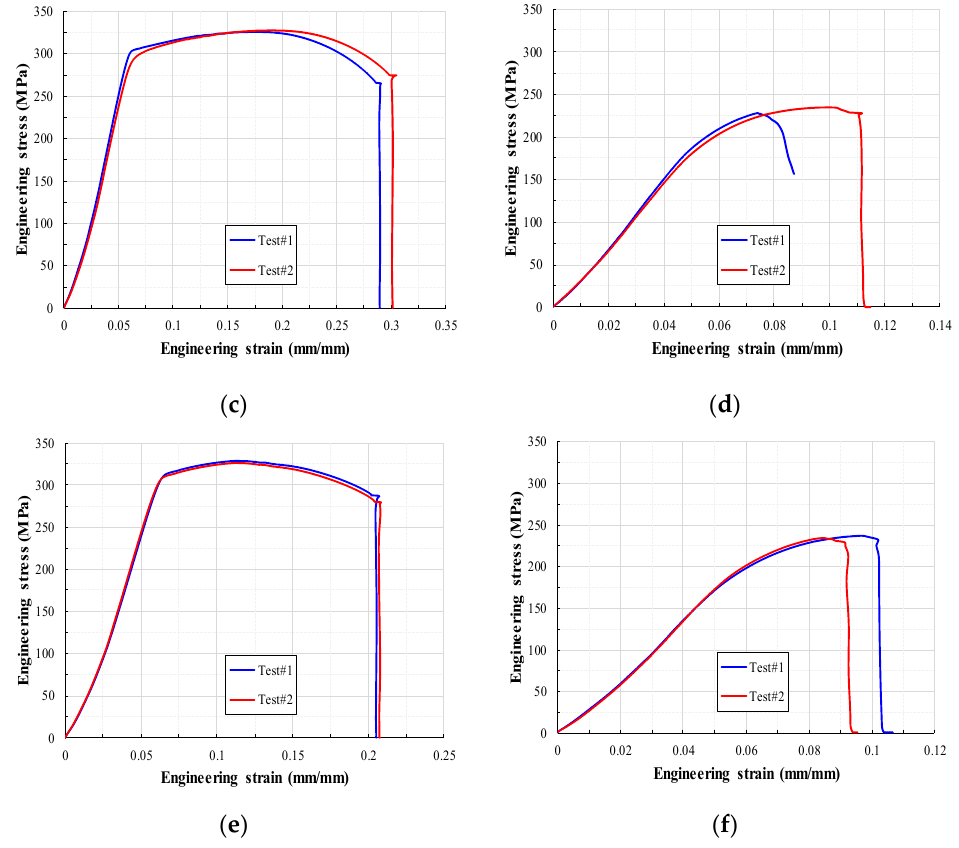
Figure 8. Engineering stress versus engineering strain curves for Al alloys: ( a ) Base metal of Al 5083 H321; ( b ) Welded metal of Al 5083 H321; ( c ) Base metal of Al 6061 T6; ( d ) Welded metal of Al 6061 T6; ( e ) Base metal of Al 6082 T6; ( f ) Welded metal of Al 6082 T6.